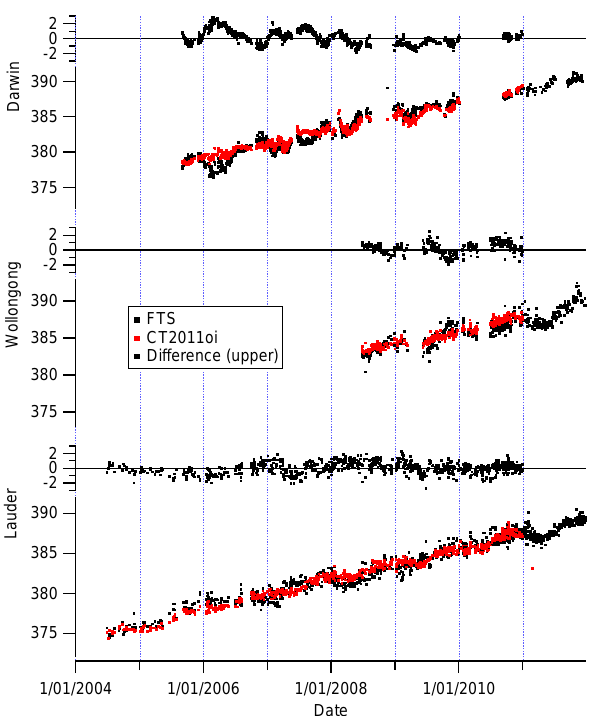
Figure 2. Measured (black) and CT2011_oi modelled (red) daily average time series of X CO at the three Southern Hemisphere TC- 2 CON sites. For each site, the difference between the modelled and measured (measured–modelled) values is given in a separate panel. Figure 3. Derived mean seasonal cycles for the FTS (black) and The model output are interpolated to the times of the FTS mea- CT2011_oi (red) time series for each site. The error bars are de- surements, and then smoothed with the FTS a priori and averaging rived from the standard deviation of the mean difference within kernel profiles. each month from a secular trend, and give an indication of the in- terannual variability. For Darwin, the MSC is derived from 2006 to 2010 inclusively, for Lauder 2005–2010 and Wollongong from only 2009–2010. For Darwin, a green trace is added to depict the mea- sured monthly averages for the year 2006. Data gaps exist due to incomplete measurement records, caused by a combination of poor measurement conditions and instrumental